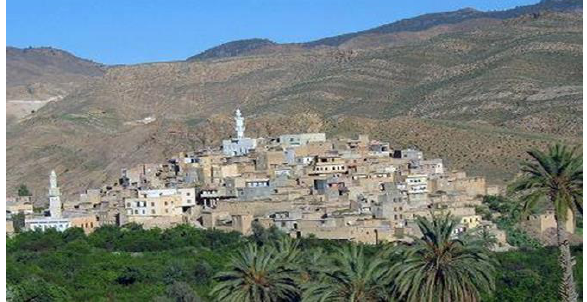
Figure 3. Menaa, Defensive Site. (Authors, 2017).